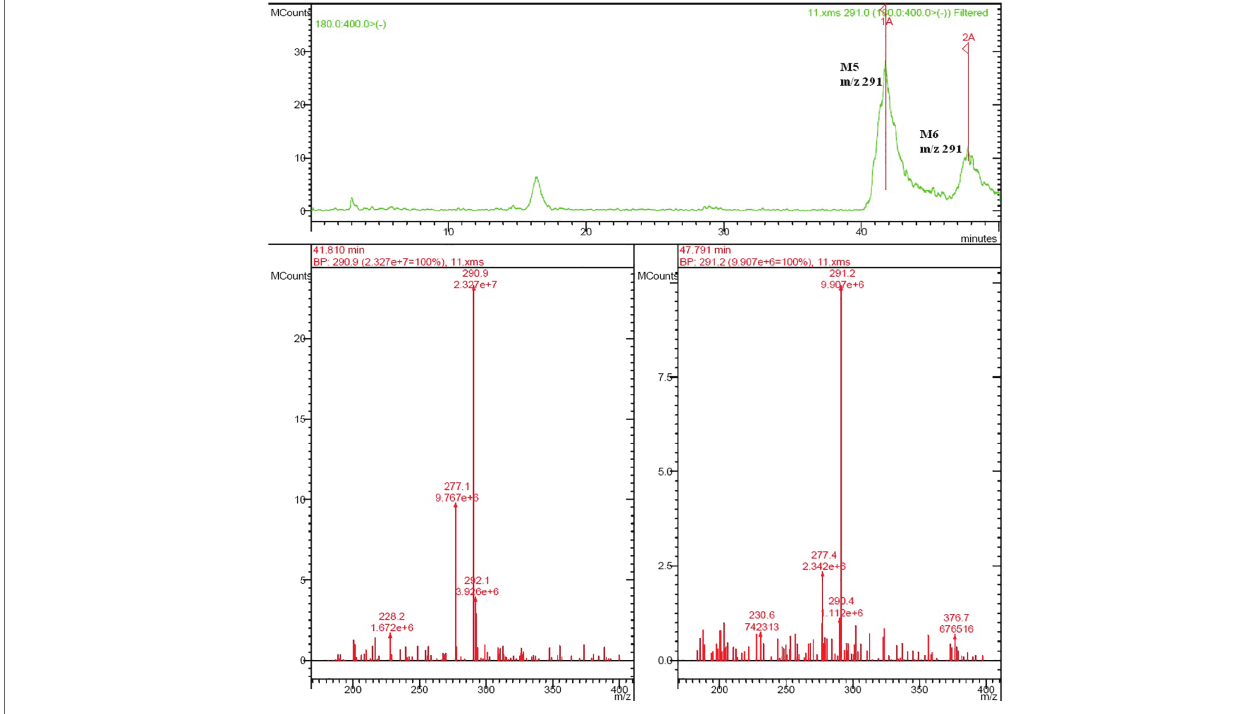
FIGURE 7 | EIC of rat urine sample at m/z 291.